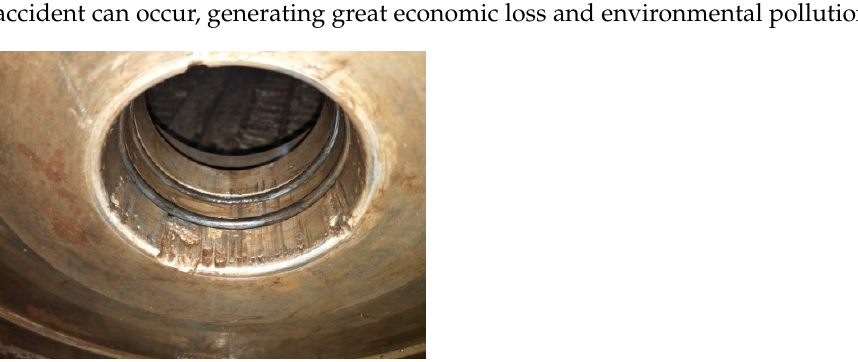
Figure 3. Eccentric wear phenomenon on the inner wall of the main diameter of a BOP.